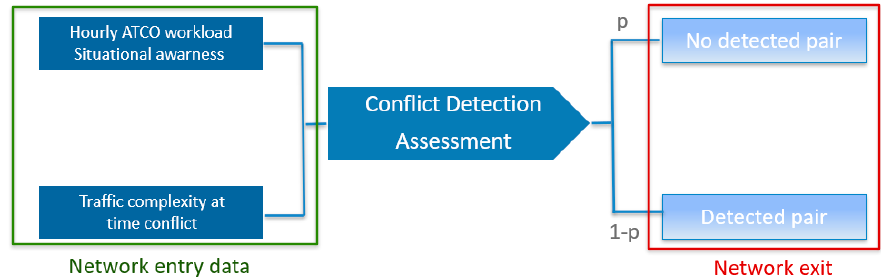
Figure 1. Conflict detection assessment network .